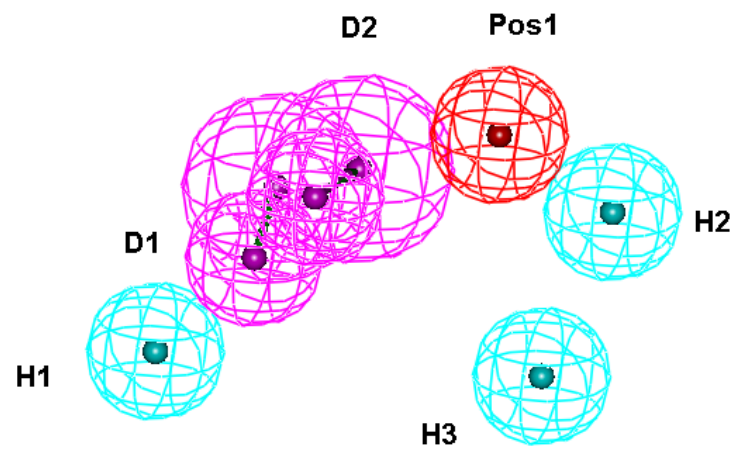
Figure 1. The structure-based comprehensive pharmacophore model for pharmacophore model-based virtual screening (PBVS). Screenshots were taken from Discovery Studio. Features of the pharmacophore models are color-coded as follows: Hydrogen bond acceptor (HBA), green; hydrogen bond donor (HBD), violet; hydrophobic (H), light blue; positive ionizable (pos), red; negative ionizable (neg), blue.